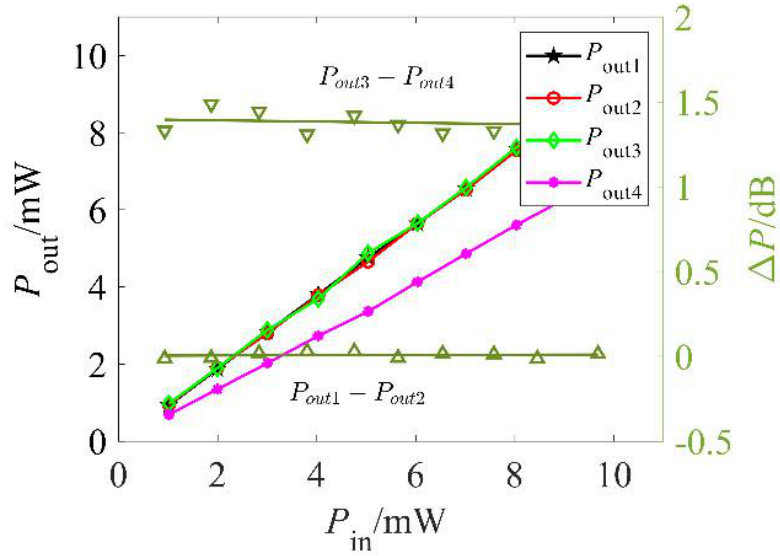
Figure 4. Optical power measurement results and comparison for four structures.